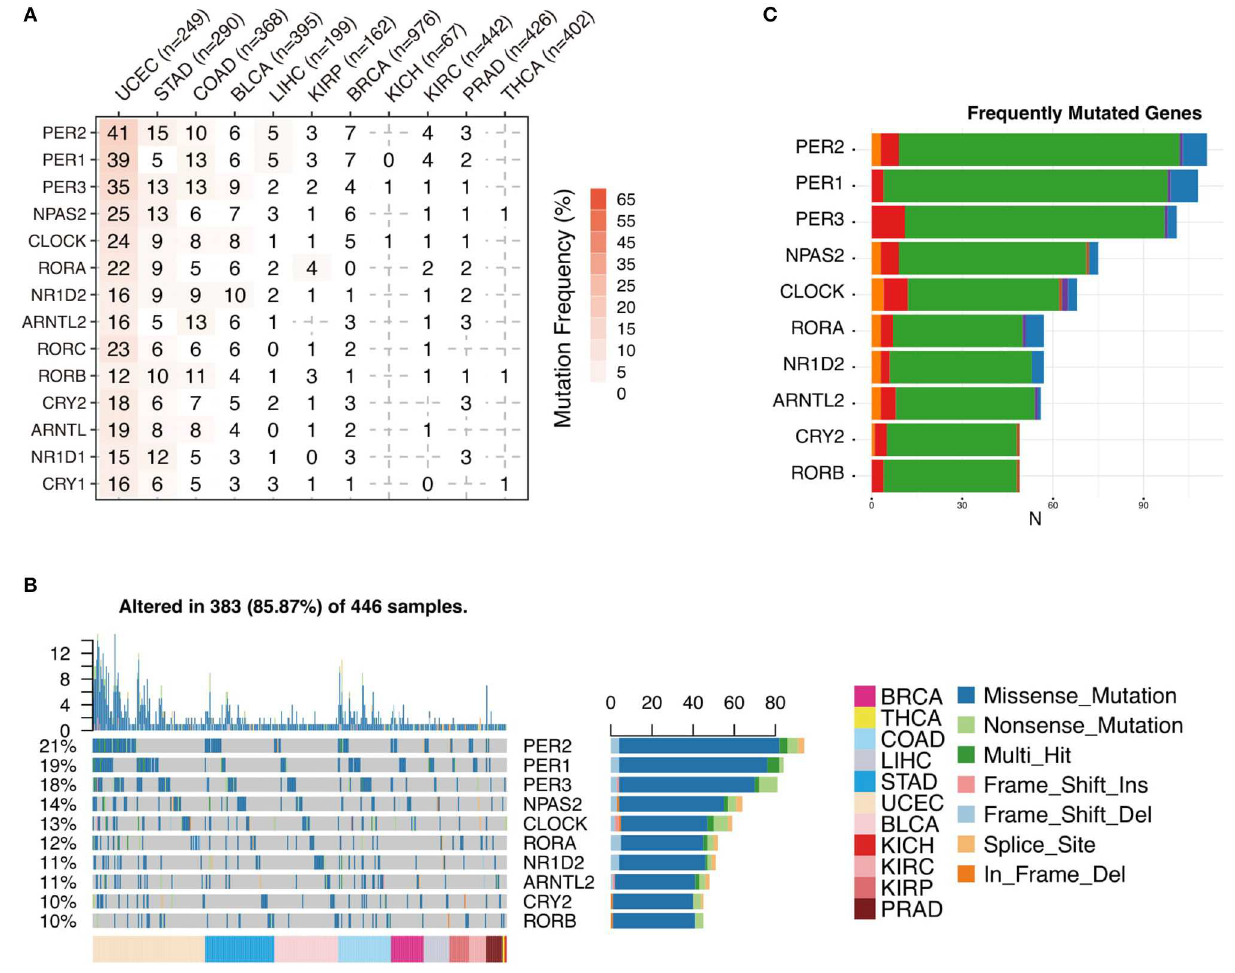
Frontiers in Immunology |